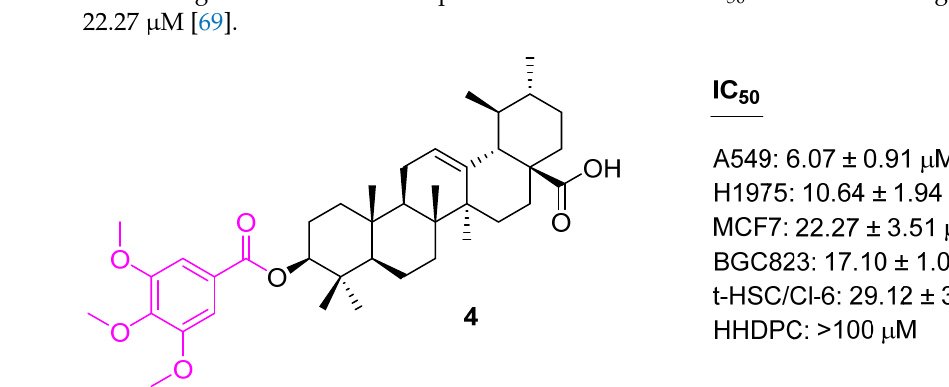
Figure 5. Structure of 4 which shows antiproliferative effect.